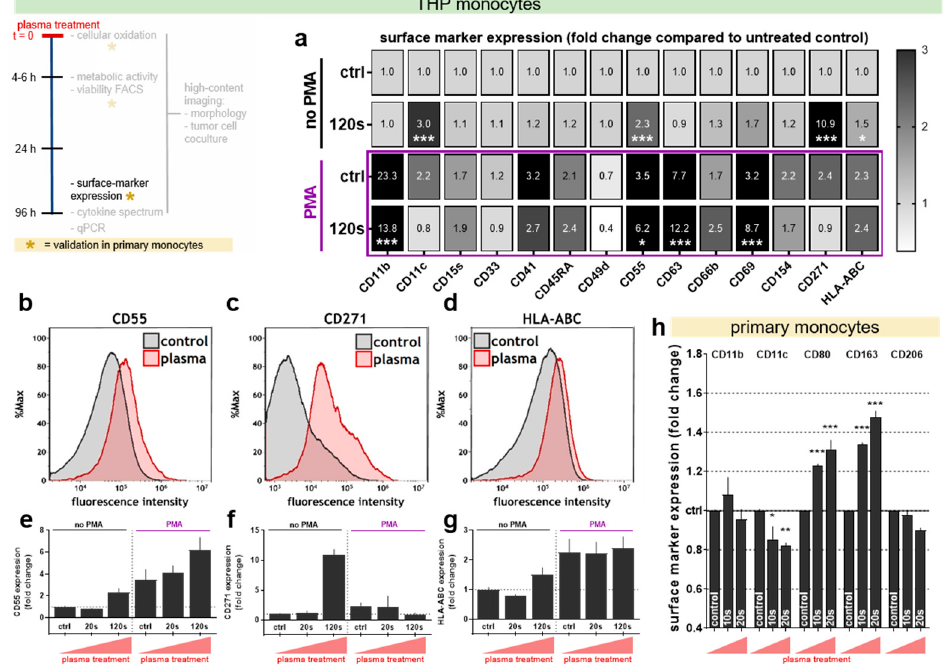
Figure 4. The cell surface marker expression in THP-1 cells and primary monocytes four days after plasma treatment. ( a ) The change of surface marker expressions of untreated and 120 s plasma-treated THP-1 cells with or without PMA in comparison to untreated control cells, displayed as a heat-map (white = decrease, light grey = no change, grey = upregulation, black = upregulation with fold change > 3. ( b – d ) The representative overlay histogram of untreated and 120s plasma-treated THP-1 cells without PMA stained with ( b ) anti-CD55, ( c ) anti-CD271 and ( d ) anti-HLA-ABC antibodies. ( e – g ) Quantification of these selected surface-markers on THP-1 cells for 0 s, 20 s, and 120 s plasma-treatment ( ± PMA). ( h ) The change of expression of 5 surface markers on primary monocytes four days after exposure to 0 s, 10 s or 20 s plasma-treatment ( ± PMA). The data are presented as the mean + SEM of three independent experiments with four technical replicates each. The statistical analysis was performed using two-way anova with Dunnett post-testing to their respective controls. The seconds (s) indicate plasma treatment time, ctrl = control.